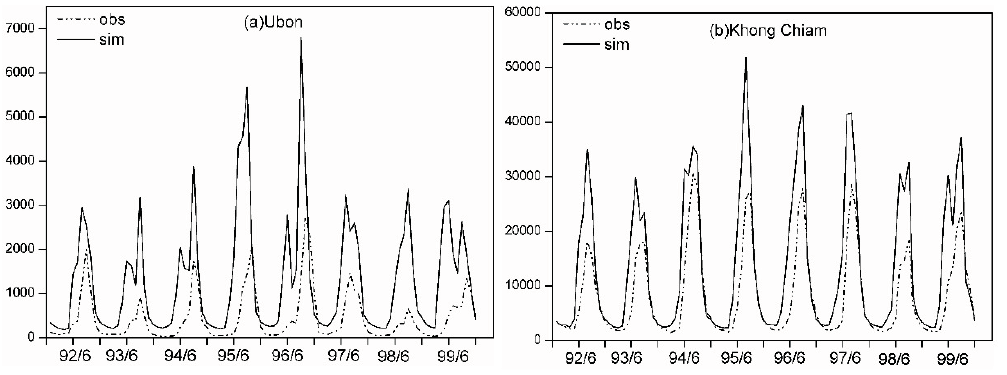
Fig. 3 Time series of monthly discharge driven by station data in